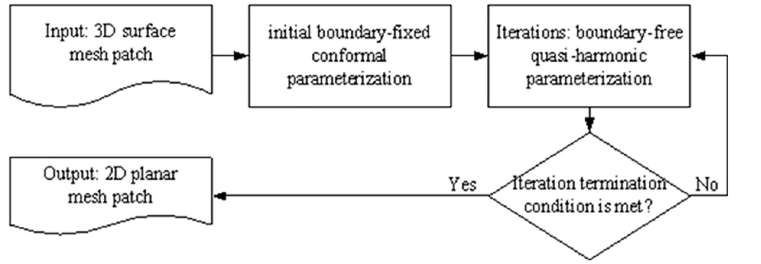
Fig 2. Novel method